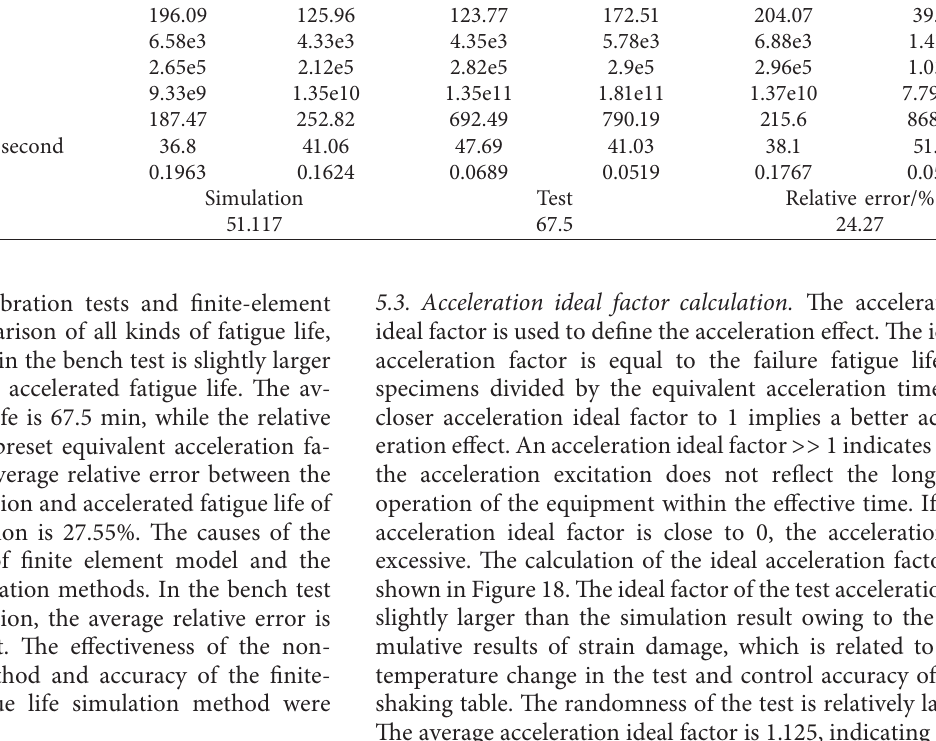
Table 6: Calculation of frequency domain characteristics of stress signal and comparison of fatigue life between test and simulation Hazard